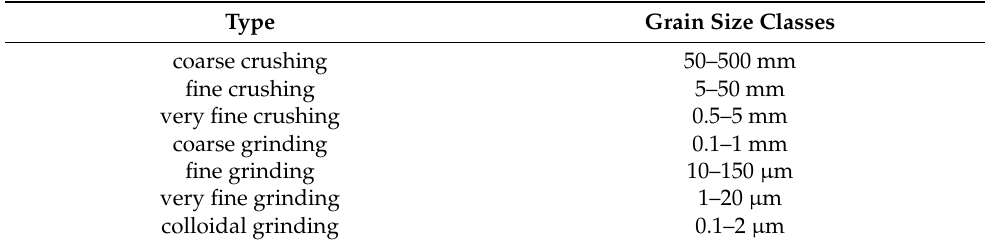
Table 3. Types of shredding depending on the grinding product size class according to [46].